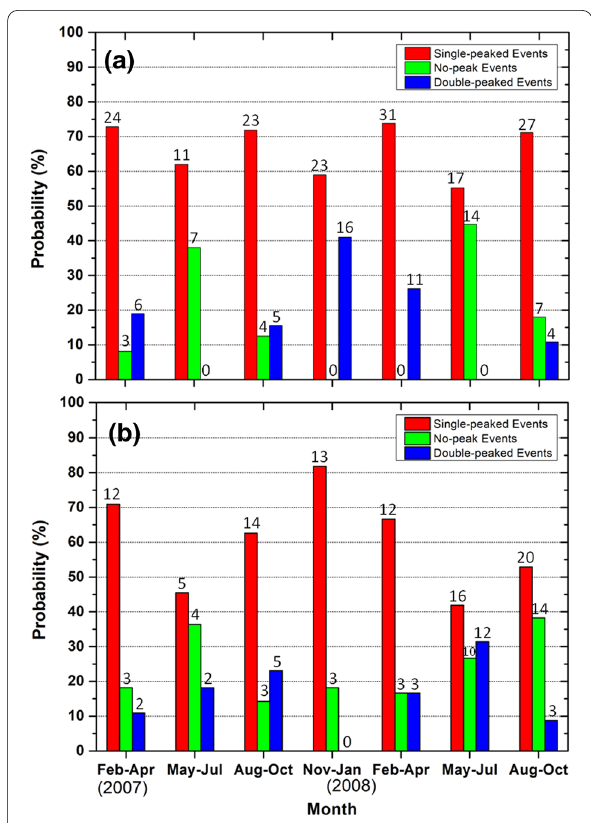
Fig. 6 Combined occurrence rates of the three types of brightness from all the orbits during the 7 seasons: a for the region between the 0° and 150° longitudes (Zone‑N); b for the region between the and 15° longitudes (Zone‑S). Single‑peaked events are in red, − double‑peaked events are in blue, and no‑peak events are in green. The numbers at the top of bar are event